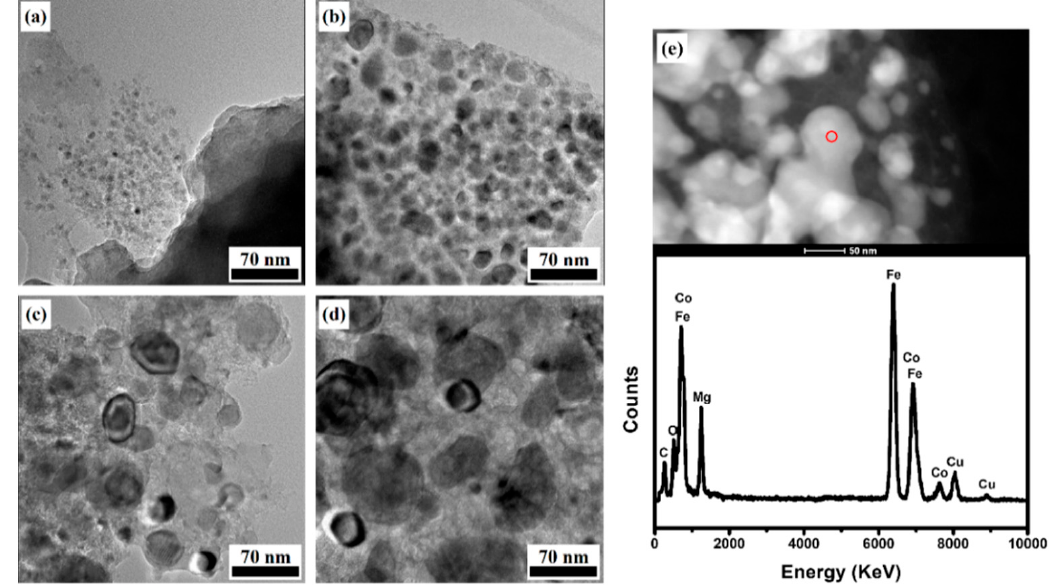
Figure 3. TEM image of catalyst particles reduced at ( a ) 600, ( b ) 700, ( c ) 800 and ( d ) 900 °C, respectively, and ( e ) TEM-EDX spectrum on the metallic catalyst (red ring).